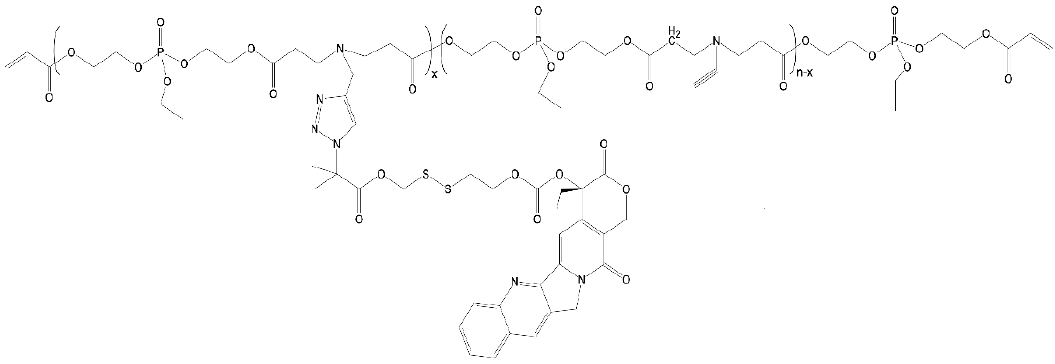
Figure 6. Structure of P(EAEP – PPA) – gss – CPT prodrug.